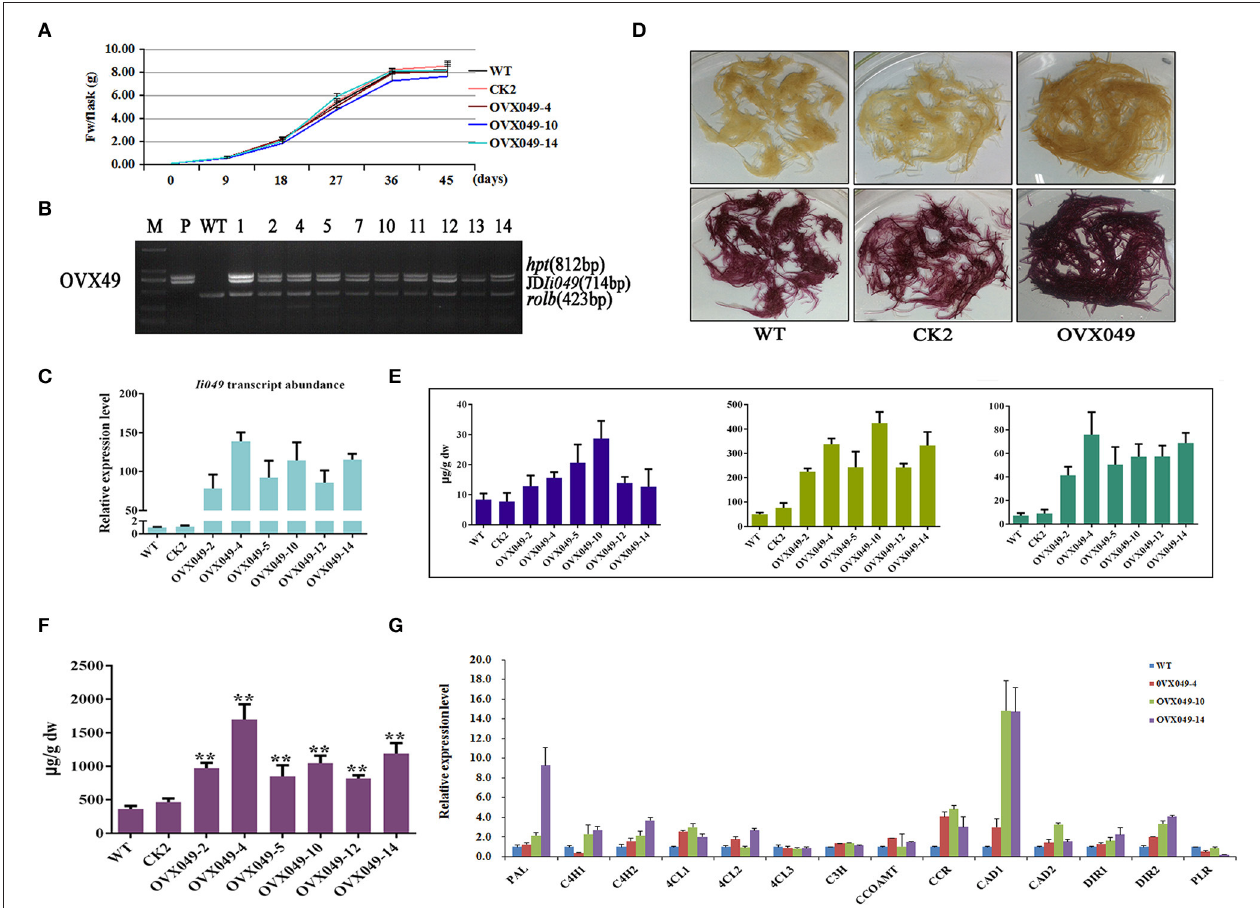
FIGURE 8 | Characterization of transgenic hairy roots overexpressing Ii049 . (A) Time course of biomass accumulation of hairy root lines WT, CK2, OVX049-4, OVX049-10 and OVX049-14. (B) Representative PCR analyses for the rolb and hpt genes and the specific gene in transgenic hairy root lines. M, DL-2000 Marker; P, the corresponding engineered bacteria (positive control); and WT, the wild-type hairy root (negative control). (C) Ii049 transcript levels. Bars indicate standard deviation. The level of significance obtained using the Student t -test is marked by the following: * P < 0.05, ** P < 0.01. (D) Phenotype of OVX049 lines before (upper) and after (lower) phloroglucinol-HCl staining. (E) HPLC-MS/MS analysis of pinoresinol, lariciresinol and secoisolariciresinol of different OVX049 lines. (F) SA content in OVX049 lines. (G) Relative expression of lignan/lignin biosynthetic genes in hairy root lines WT, OVX049-4, OVX049-10, and OVX049-14. Each data point is the average of three biological replicates. Bars indicate standard deviation. The level of significance obtained using the Student t -test is marked by the following: * P < 0.05, ** P <